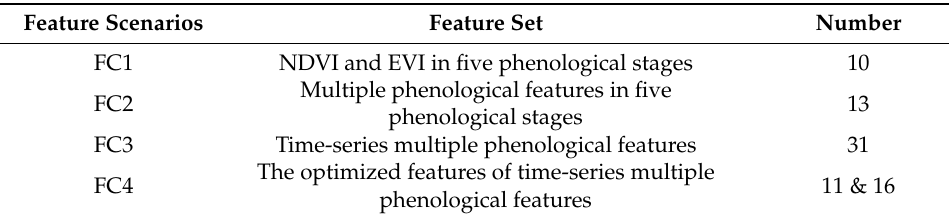
Table 2. Detailed information on four feature scenarios.